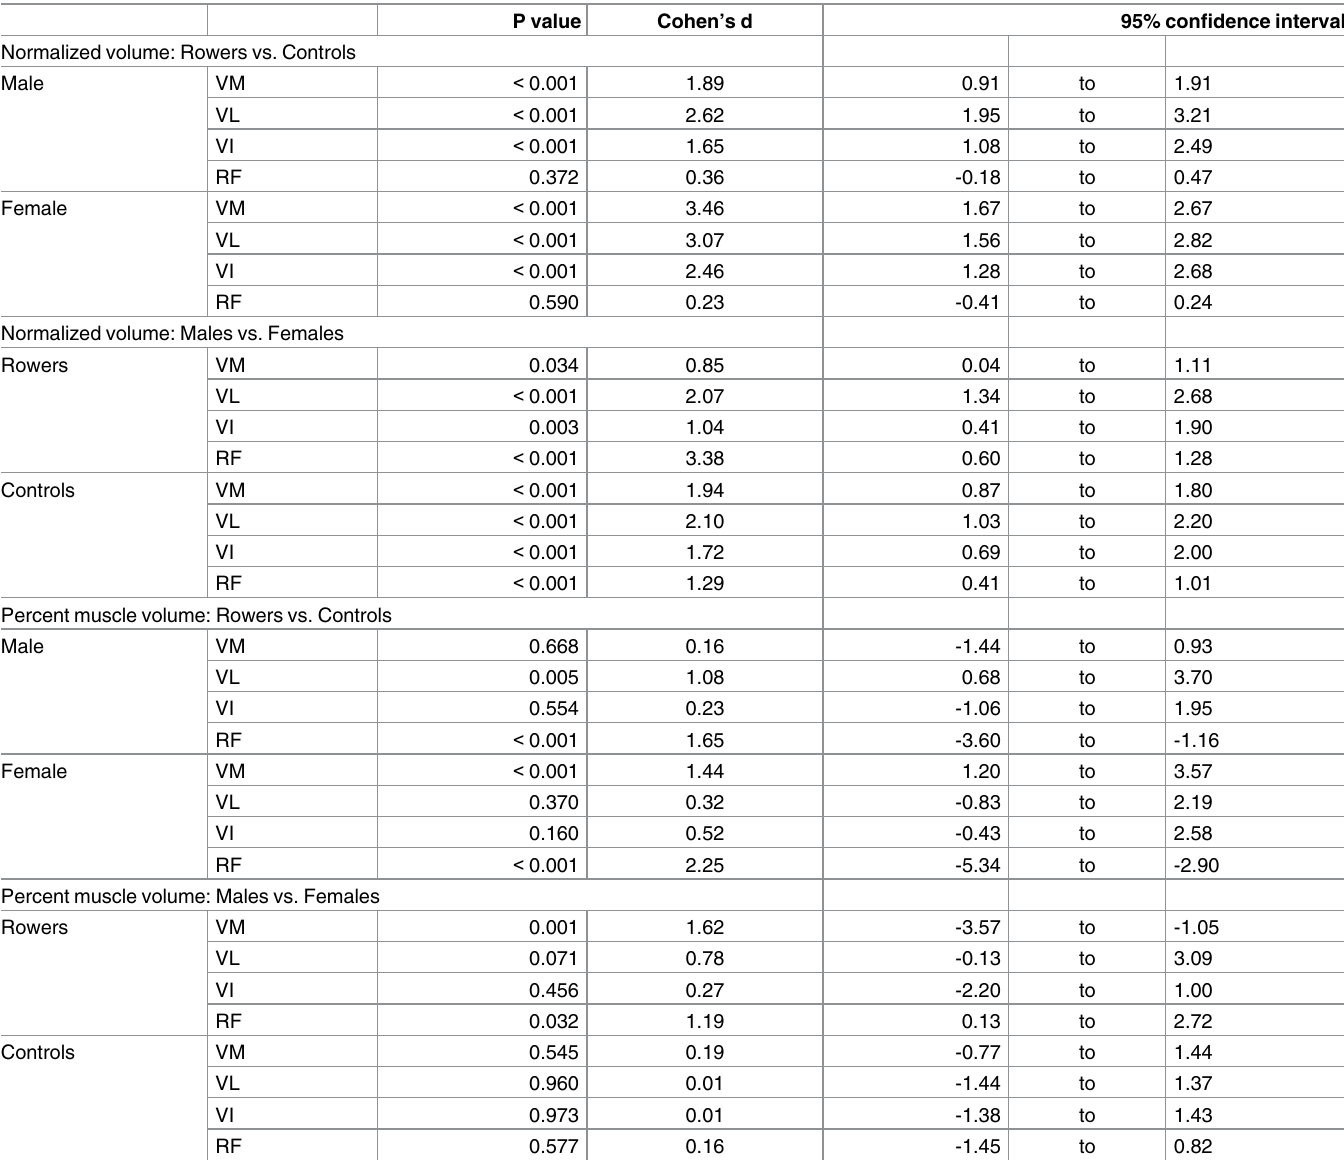
Table 1. Statistical results of the difference between rowers and untrained control subjects, and between males and females. P value Cohen’s d 95% confidence interval Normalized volume: Rowers vs. Controls Male